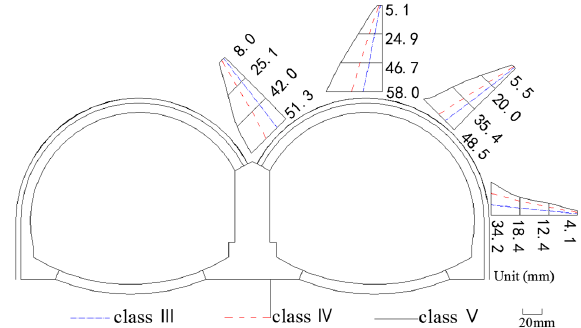
Figure 12. Final distribution of the internal displacements in three different classes of rock masses (class III, IV and V) and the values in the figure represent the internal displacements in class V surrounding rocks.